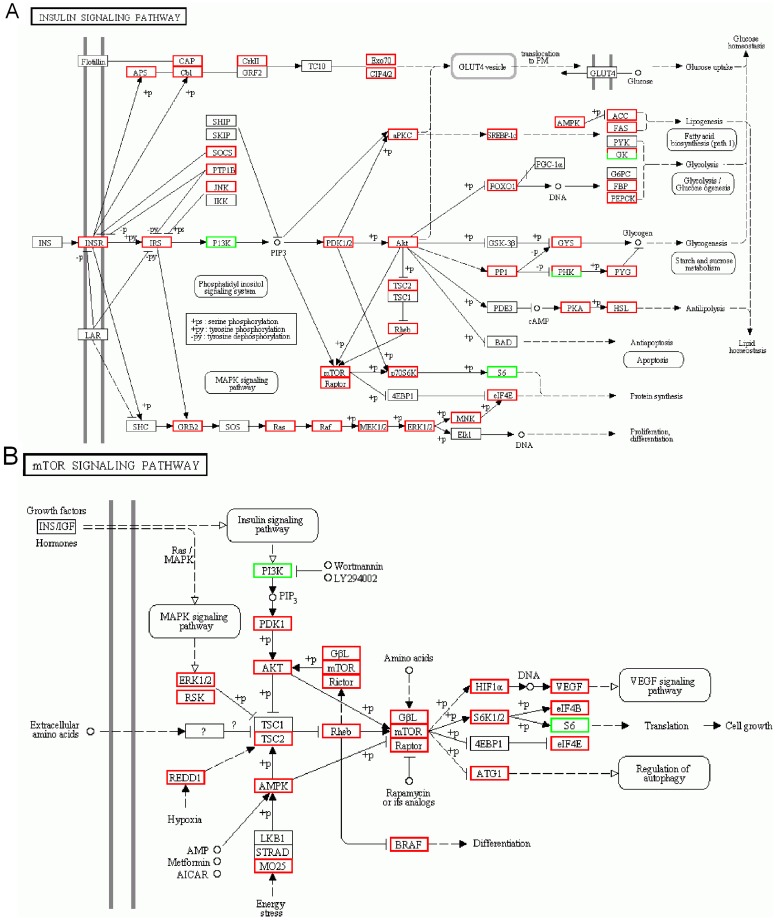
Insulin and mTOR signaling pathways affected by artificial diet feeding.(A) Insulin signaling pathway. (B) mTOR signaling pathway. Red and green frames indicate genes and enriched functions that were up- and down-regulated in artificial diet-fed (AD_1) and prey-fed (CY_1) treatments.